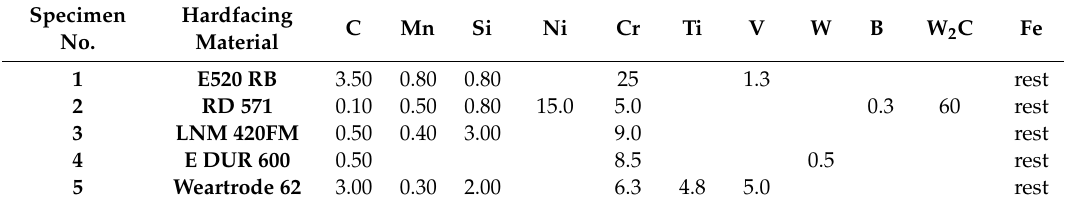
Table 2. Chemical composition (wt.%) of input materials for realization of hard surfacing. Specimen